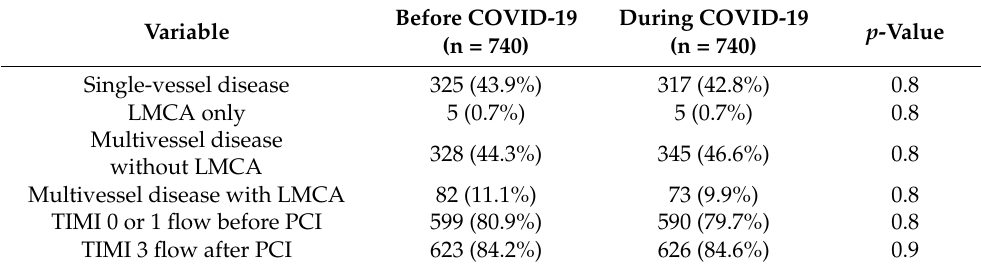
Table 2. Angiographic characteristics after propensity score matching.